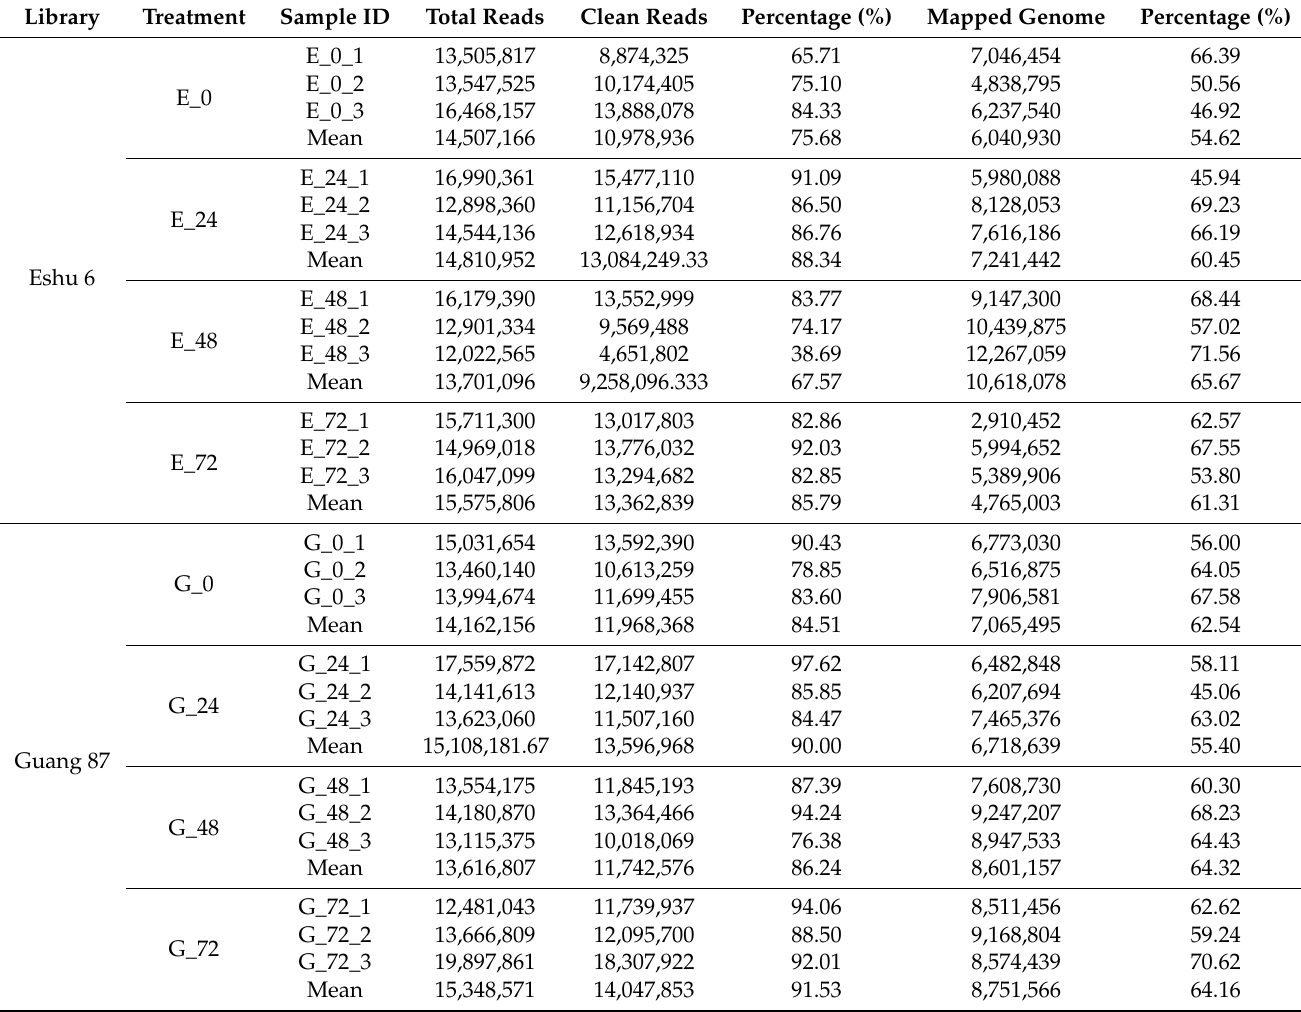
Table 1. High-throughput sequencing data statistics for different